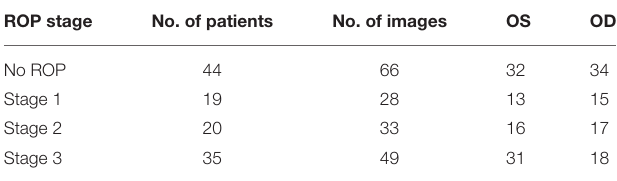
TABLE 1 | Details of data used in this